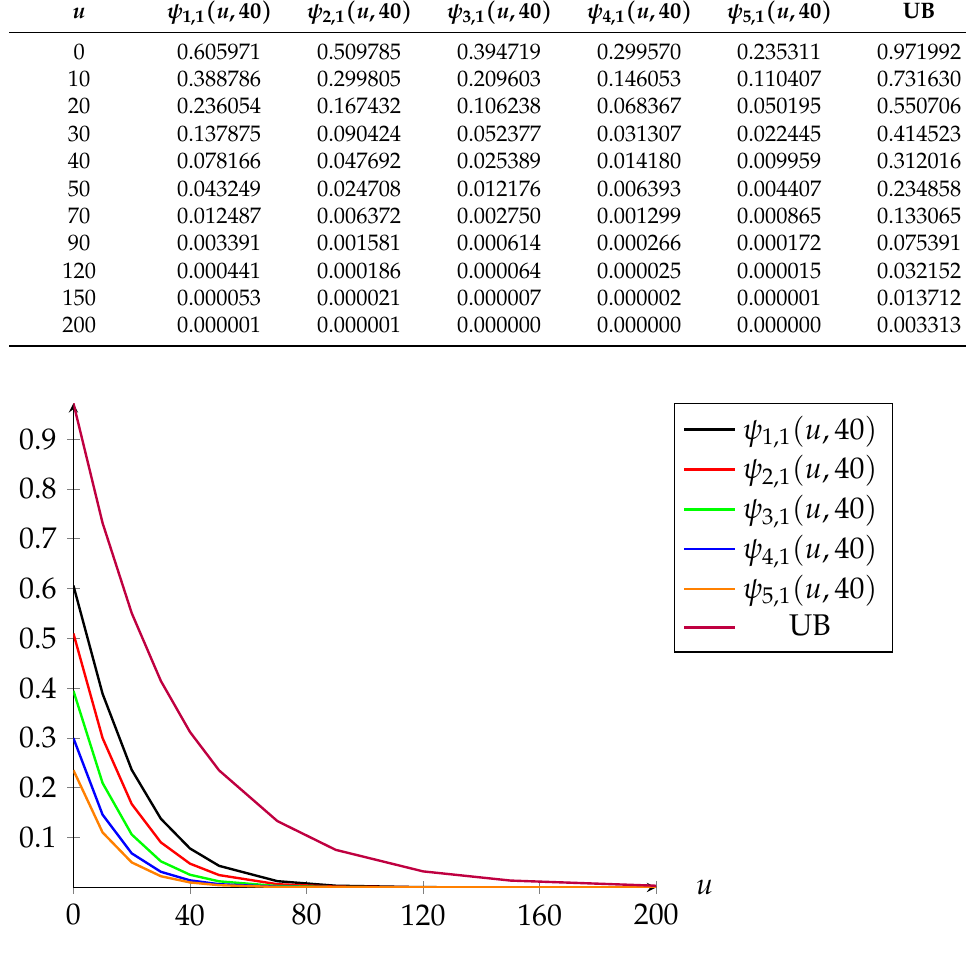
Figure 3. ψ i ,1 ( u ,40 ) with the upper